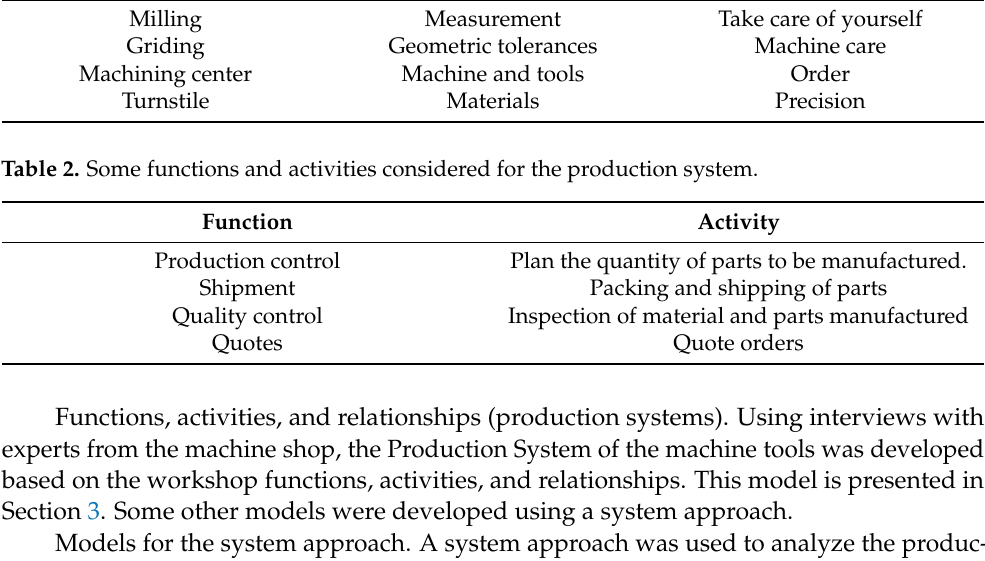
Table 1. Some of the machines, knowledge, and responsibilities considered. Machine